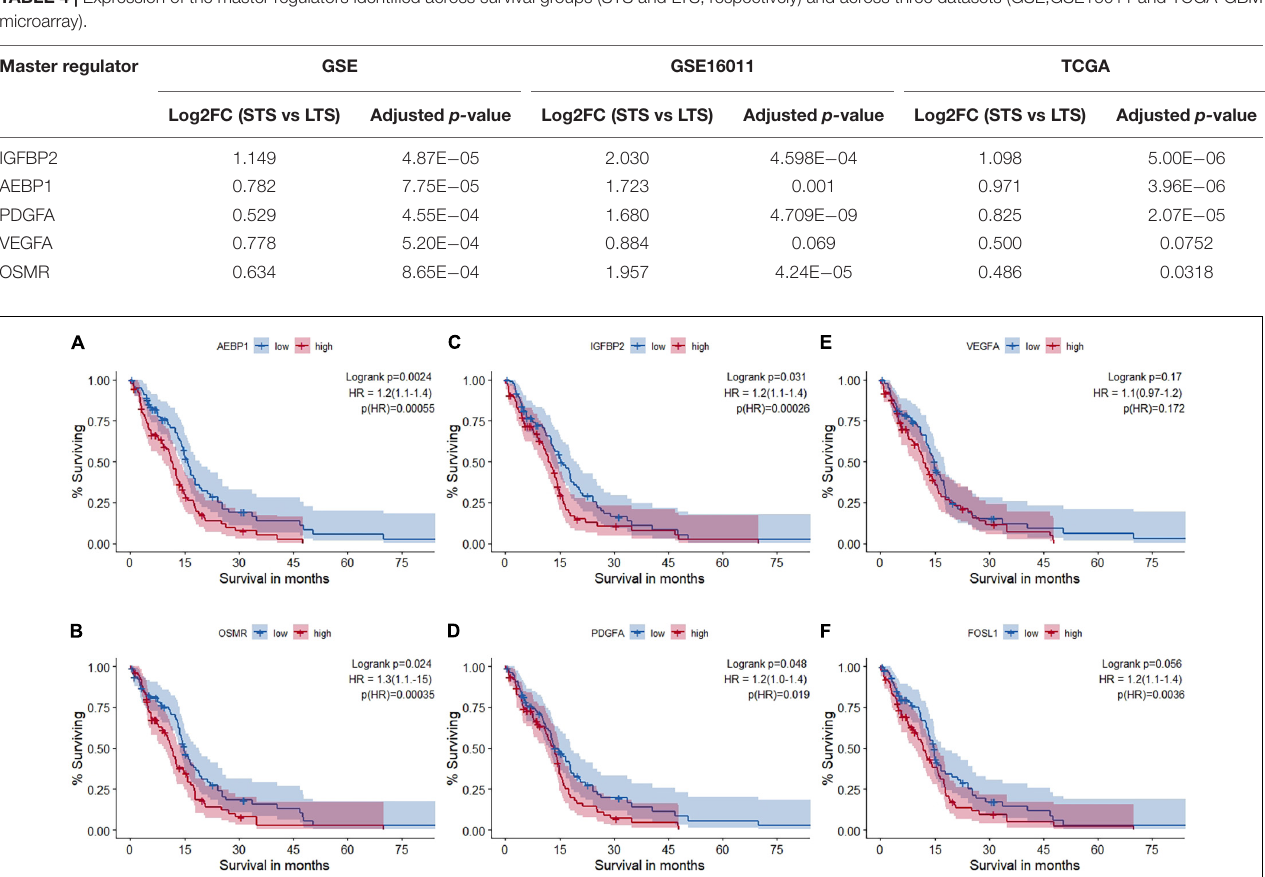
FIGURE 4 | Survival analysis using RNA-seq data of The Cancer Genome Atlas glioblastoma (TCGA-GBM) cohort. (A) AEBP1, (B) OSMR, (C) IGFBP2, (D) PDGFA, (E) VEGFA, and (F) FRA-1 (FOSL1). Out of the five master regulators, all but VEGFA (AEBP1, OSMR, PDGFA, and IGFBP2) had a statistically significant impact on survival. Hazard ratio (HR) and statistical significance [ p (HR)] according to Cox survival estimates are